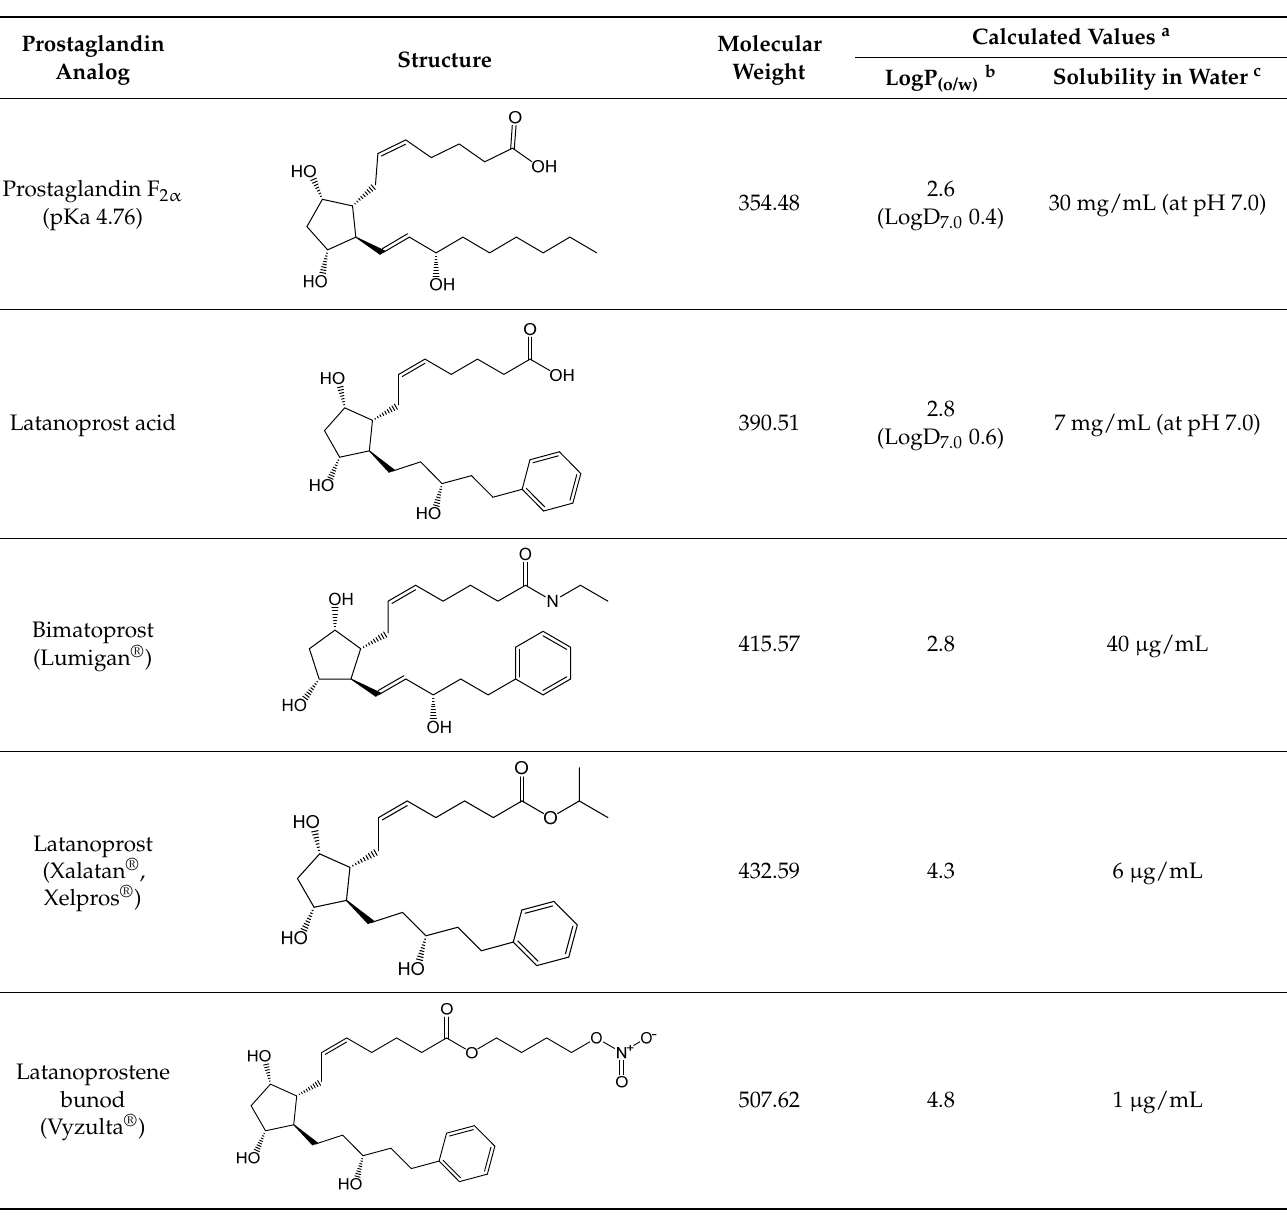
Table 1. Structure and physicochemical properties of prostaglandin F 2 α and its analogs, which are currently used in ophthalmology.